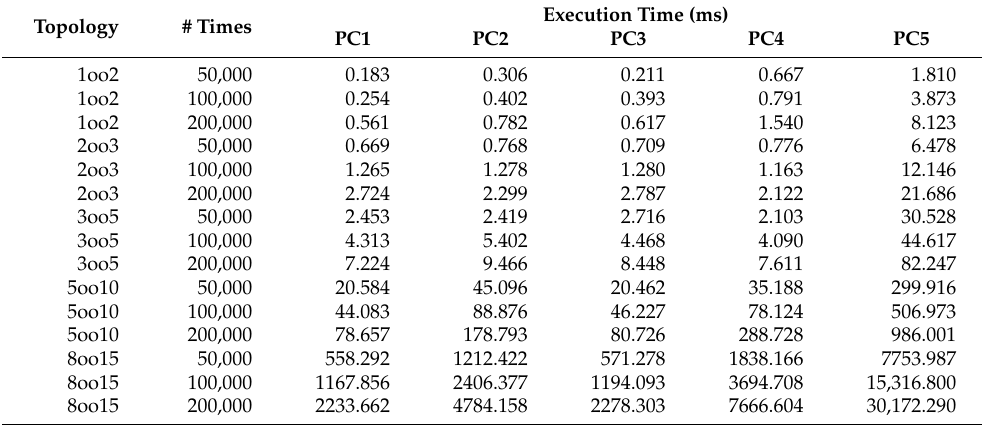
Table 9. Performance evaluation of N /2oo N generic block.